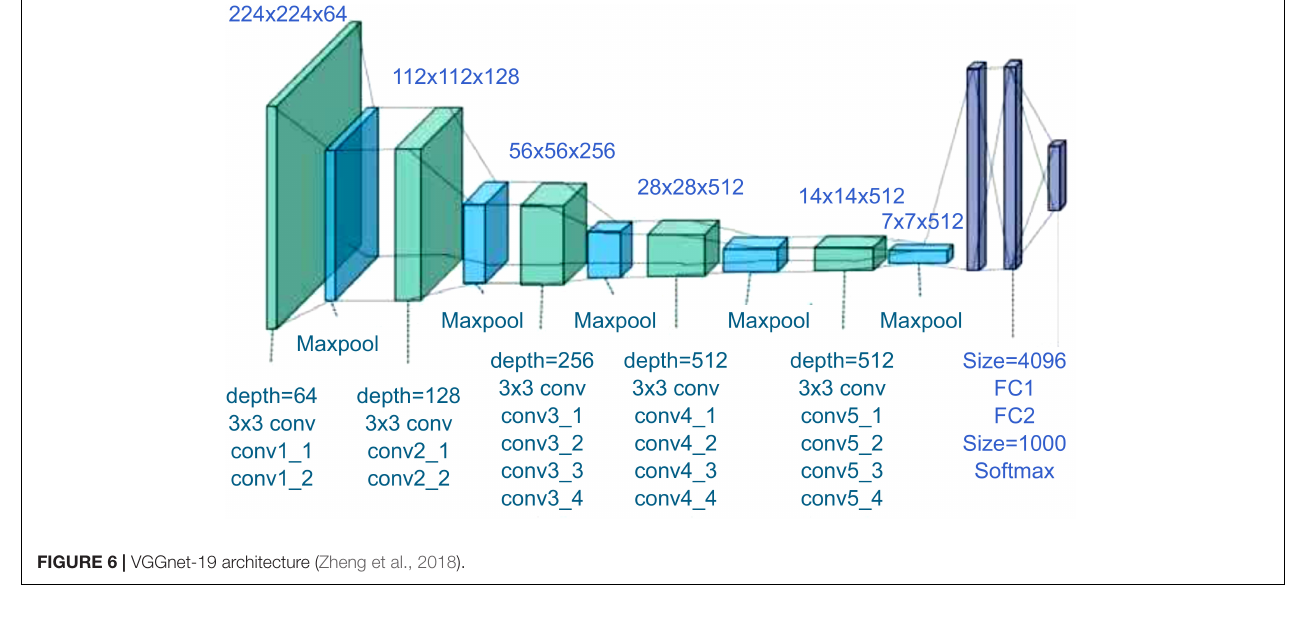
FIGURE 6 | VGGnet-19 architecture (Zheng et al., 2018).